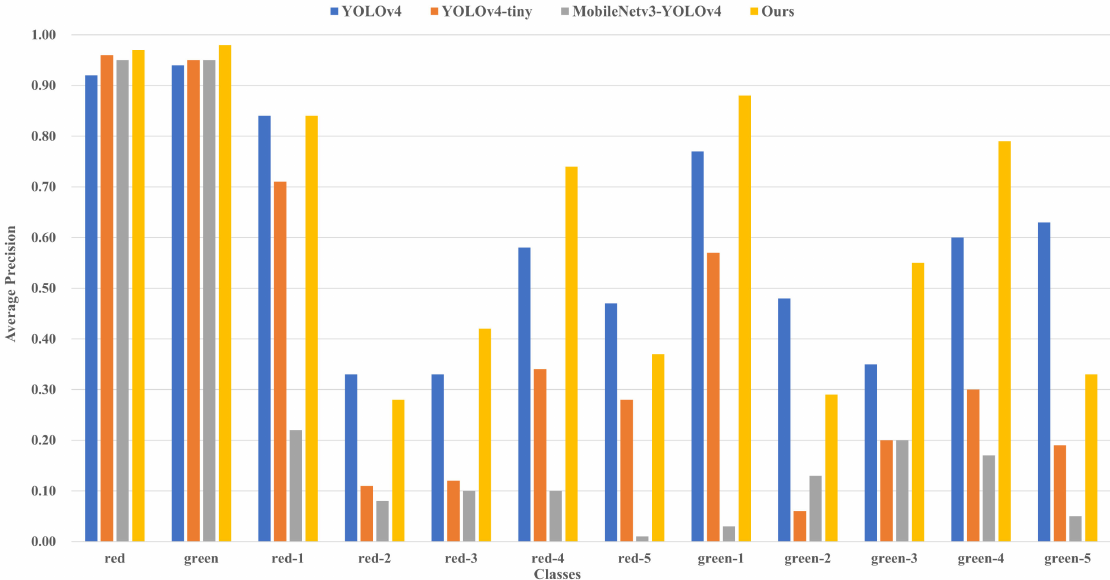
Figure 10. The accuracy comparison of each class in different